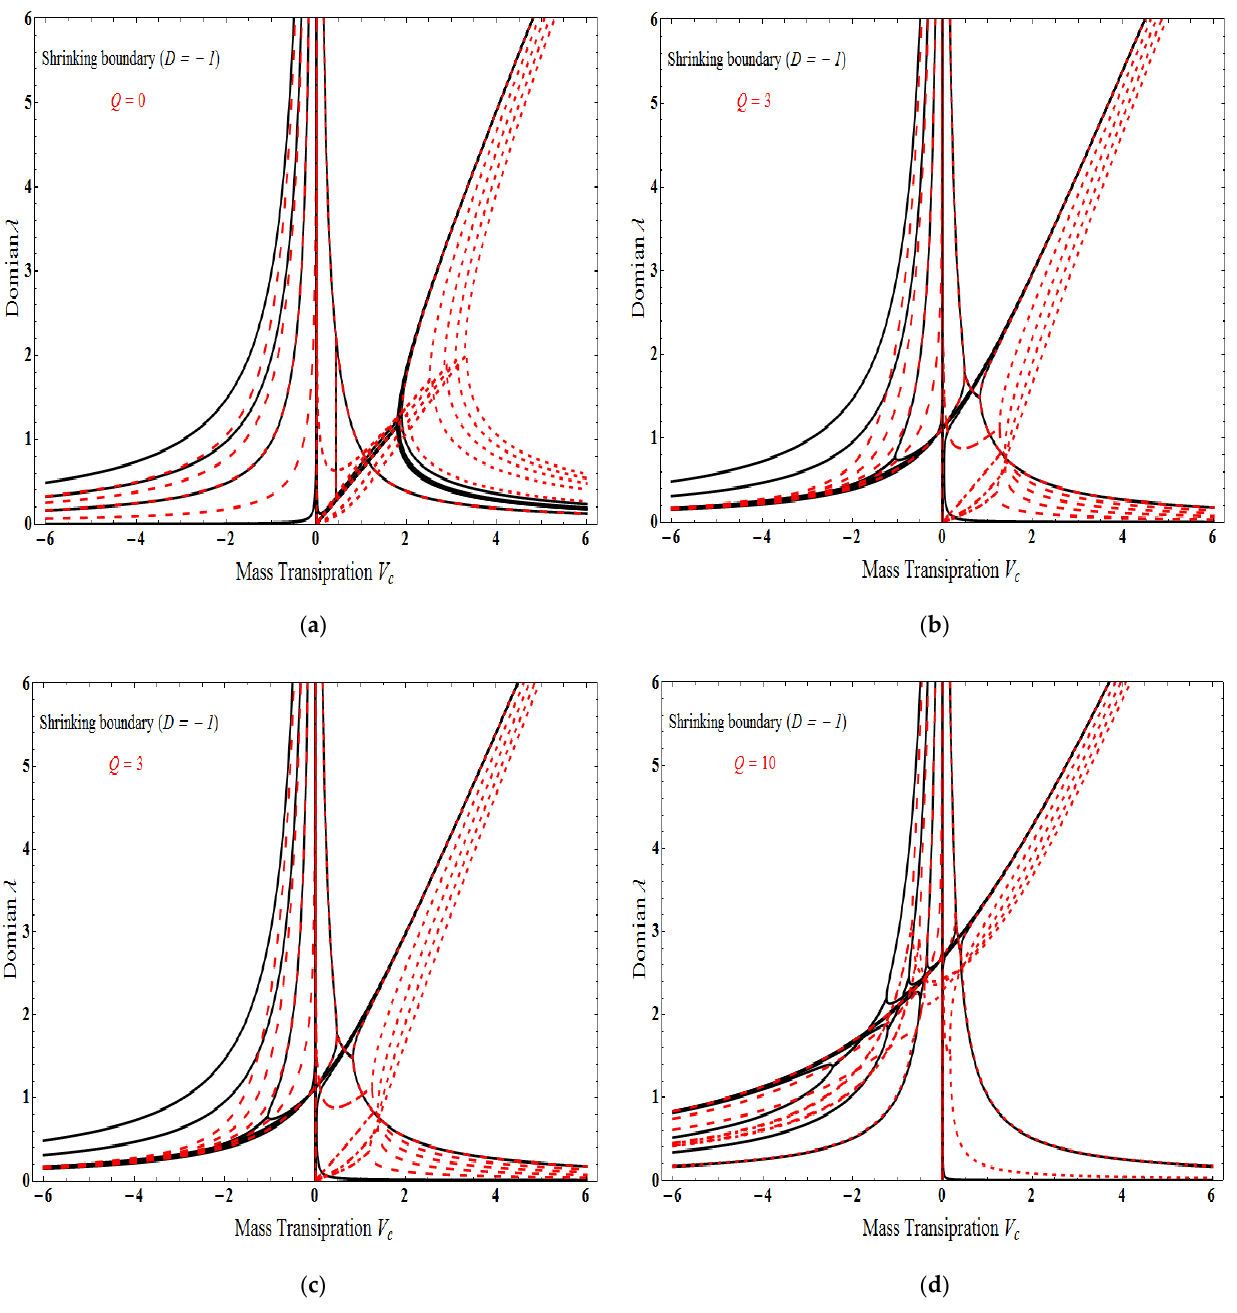
 = . Chandrasekhar’s number Figure 3. Influence of domain λ versus mass transpiration V c for several values β v = 0, 1, 2, 3, 4. Chandrasekhar’s v